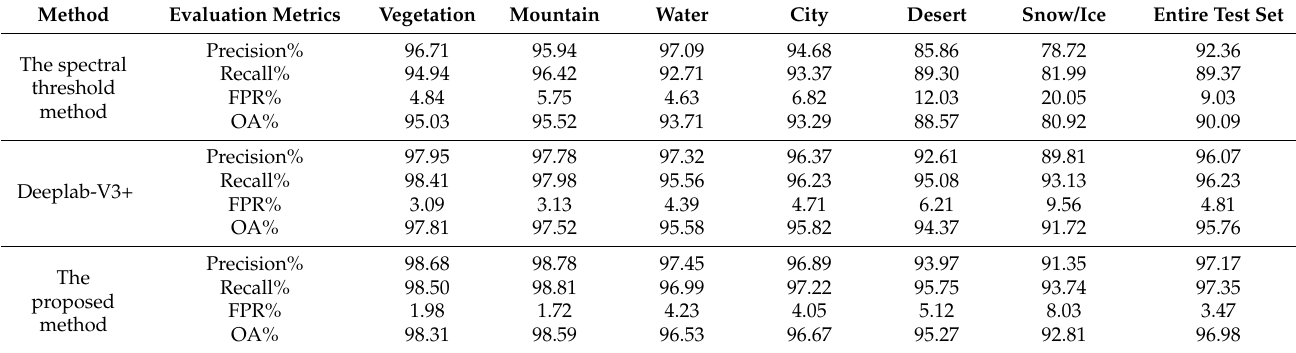
Figure 10. Comparison of the cloud-detection performance by different methods. ( a ) The original RGB image; ( b ) the ground truth; ( c ) the result of the spectral threshold method; ( d ) the result of DeepLab-V3+; ( e ) the result of the proposed method. The coordinates of the first row are 89.3E and 31.4N, the second row 117.0W and 38.9N, the third row 108.6E and 22.2N, and the fourth row 103.3E and 33.0N. Table 6. Assessment of the detection results by different methods in VNIR